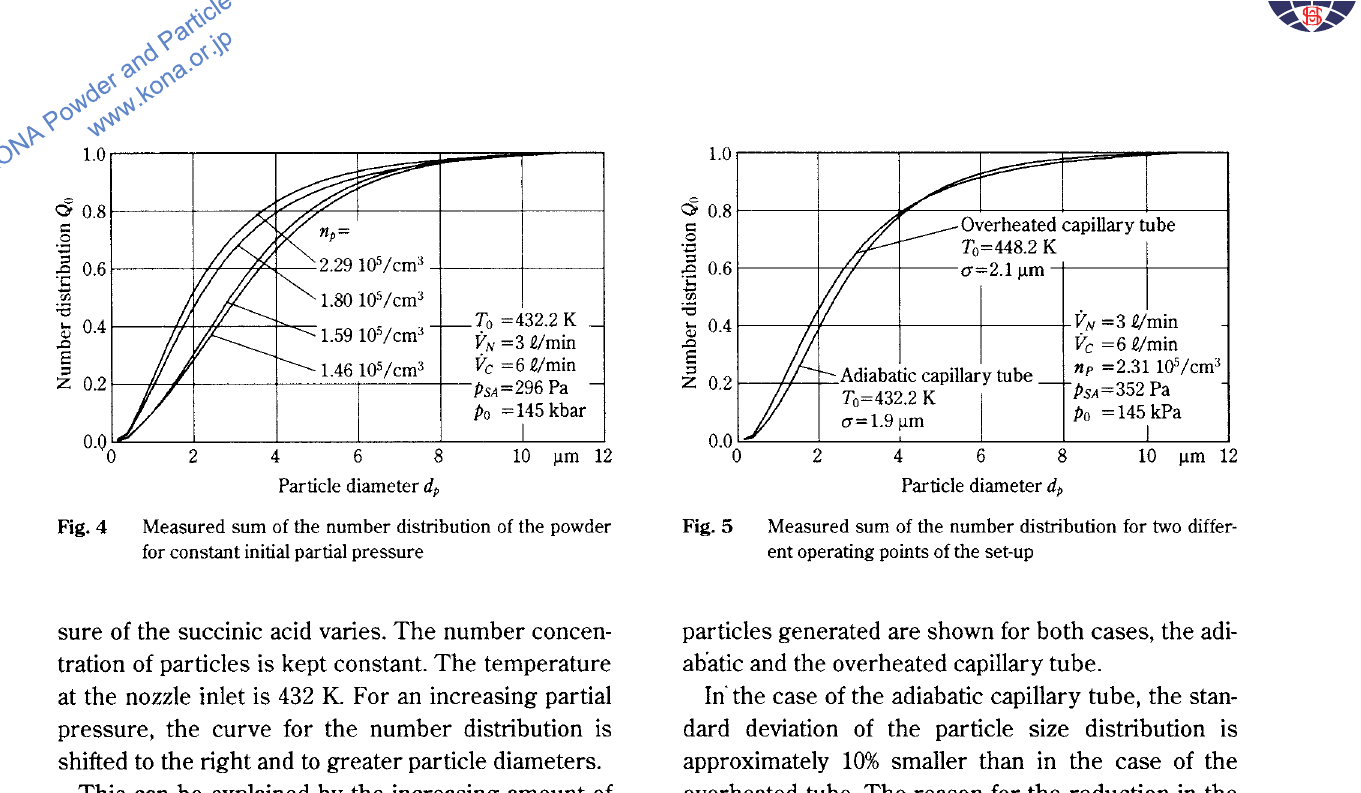
Measured sum of the number distribution of the powder for constant initial partial pressure